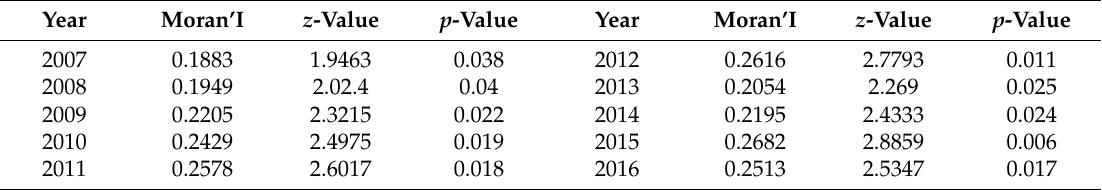
Table 3. Moran’s I index of GTI of 30 provinces and cities in China in 2007–2016.